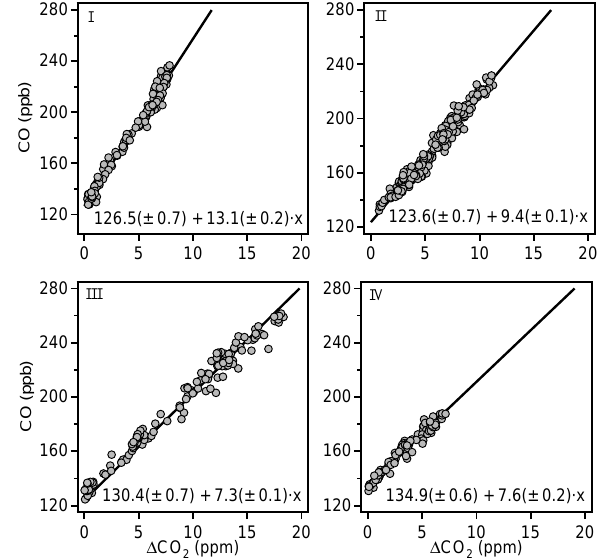
Fig. 4. Scatter plot of CO versus CO 2 above background ( 1 CO 2 ) for the four selected pollution events. The linear fit results with the 1 σ uncertainty (in parentheses) are also given. Since absolute CO mixing ratios are used, the intercept of the regression corresponds to the continental background CO level. The slope is indicative for the combustion